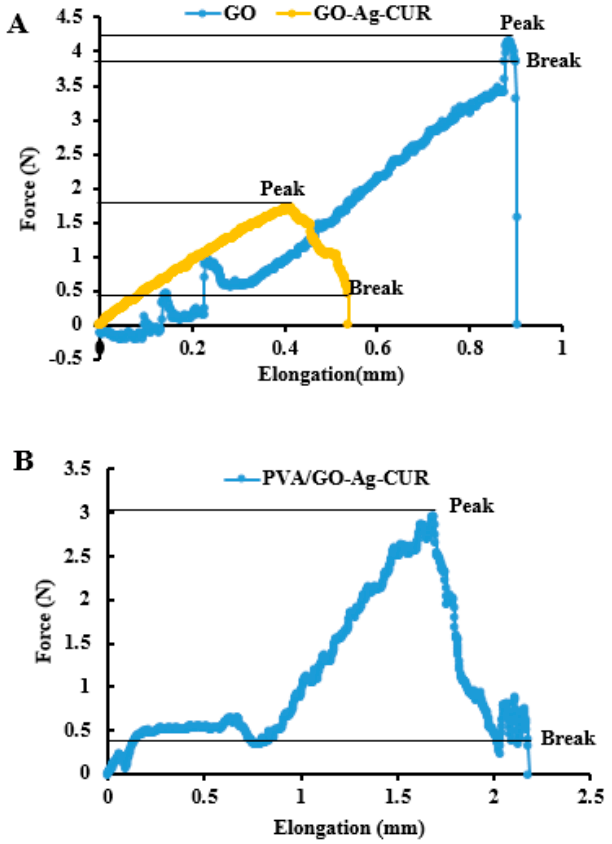
Figure 7. ( A ) The mechanical analysis of GO and GO-Ag-CUR nanostructure ( B ) PVA/GO-Ag-CUR nanofiber.